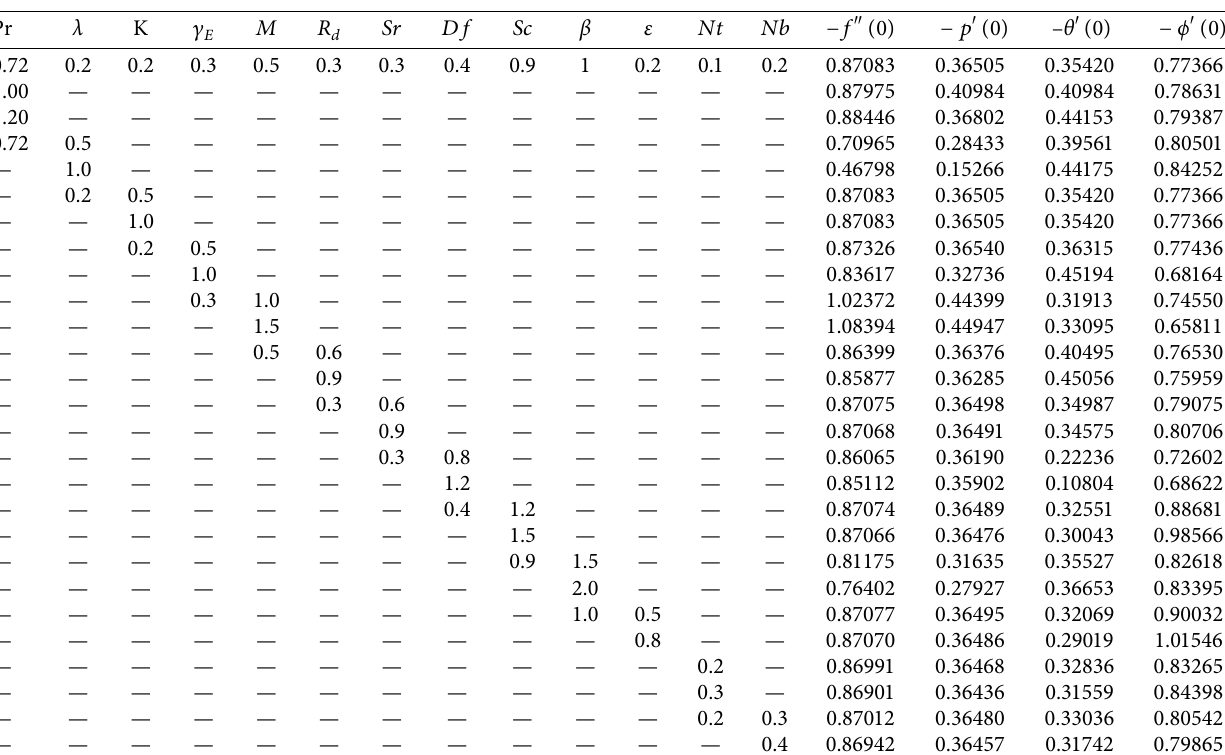
Table 6: Numerical values of local skin friction coefficient − f ″ ( 0 ) , local wall couple stress − p ′ ( 0 ) , local Nusselt number – θ local Sherwood number − ϕ ′ ( 0 )